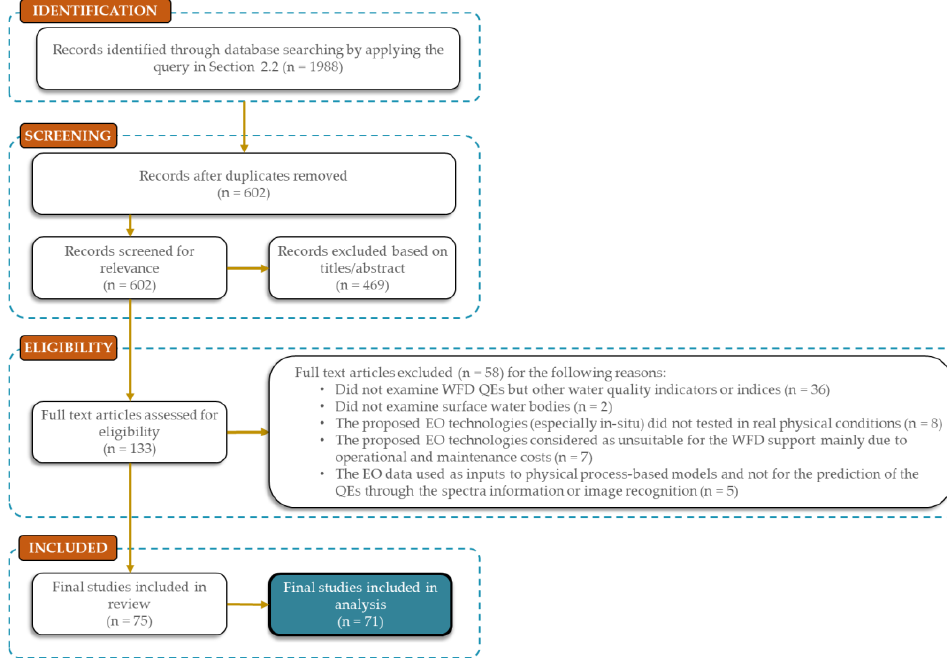
Figure A1. PRISMA methodology flow diagram adopted in this work.